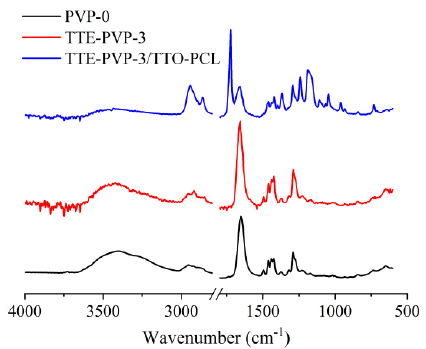
Figure 3. FTIR results for pure PVP-0, TTE-PVP-3, and TTE- PVP-3/TTO-PCL.